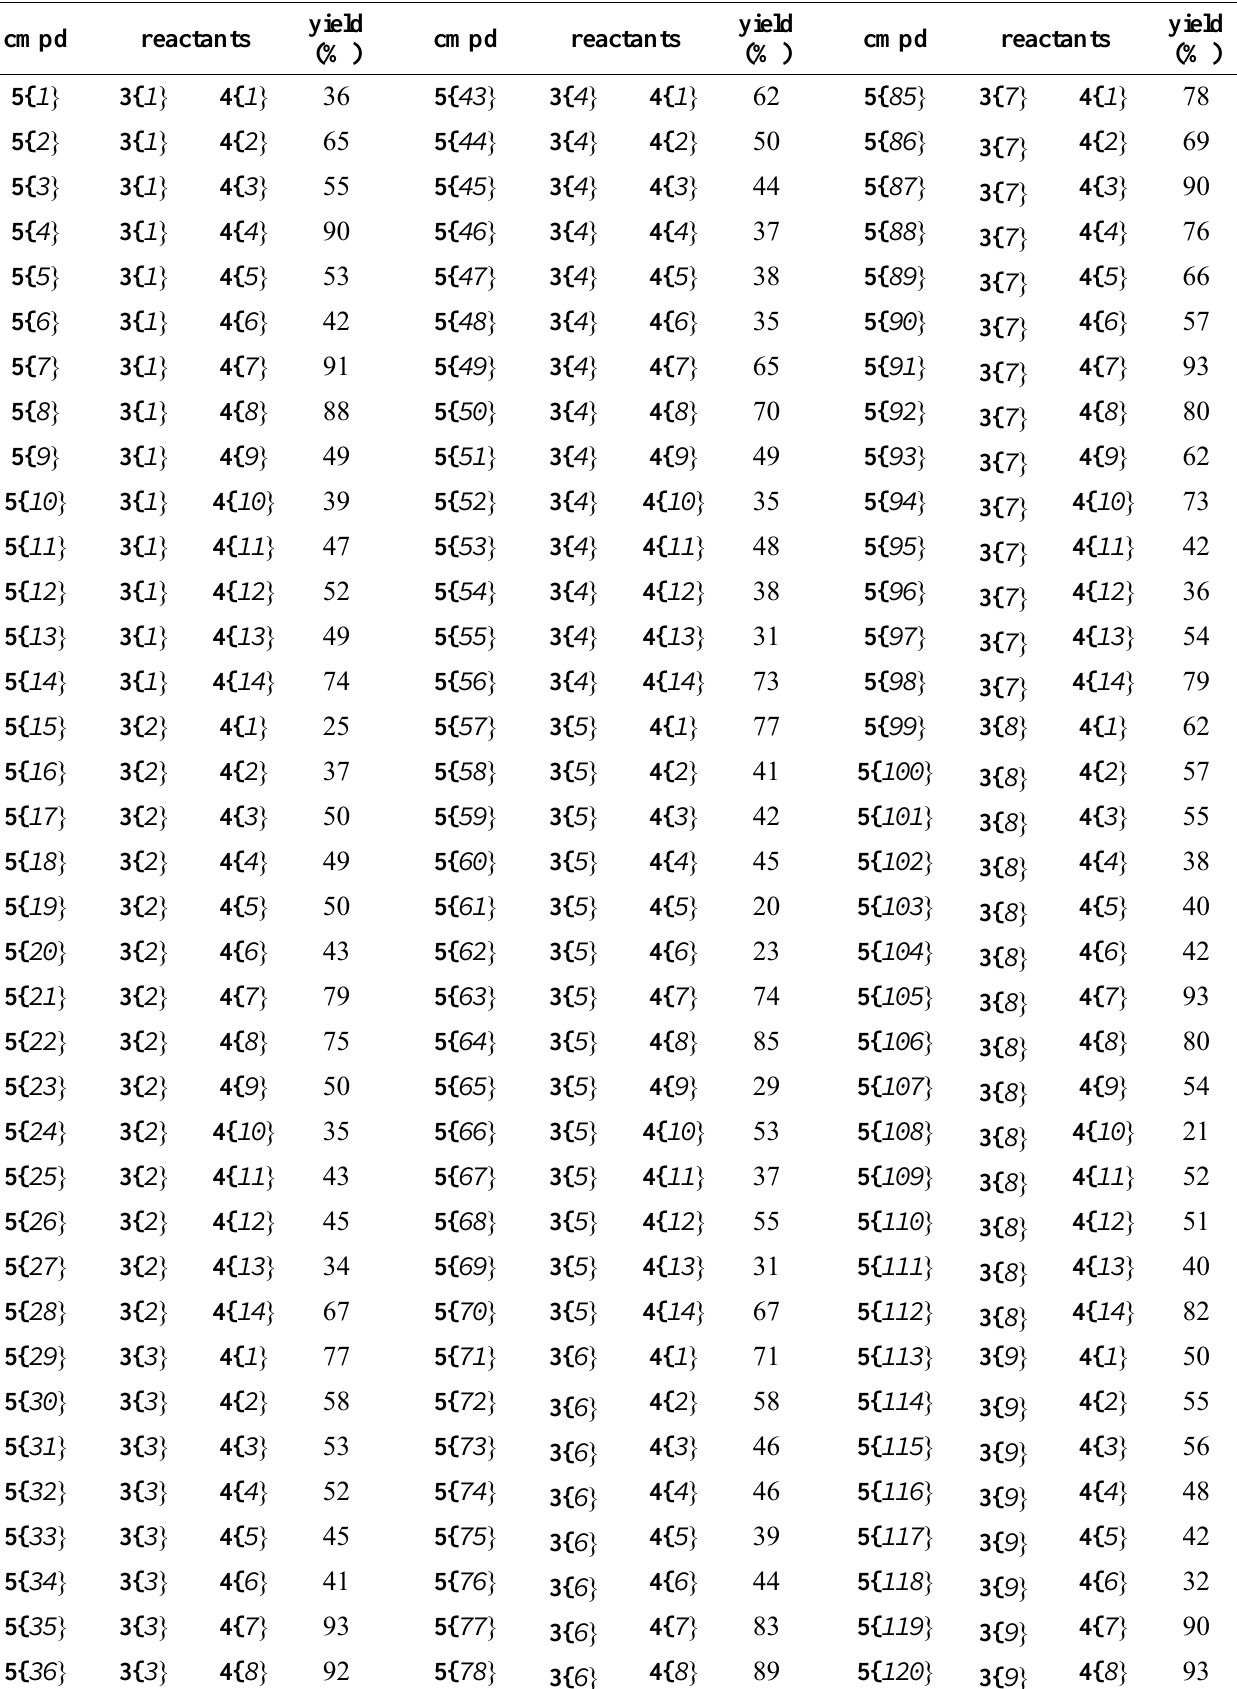
Table 4 . Amino Acid Ester—Alkanamine Disubstituted I45DCs, 5 { 1 - 63 }.